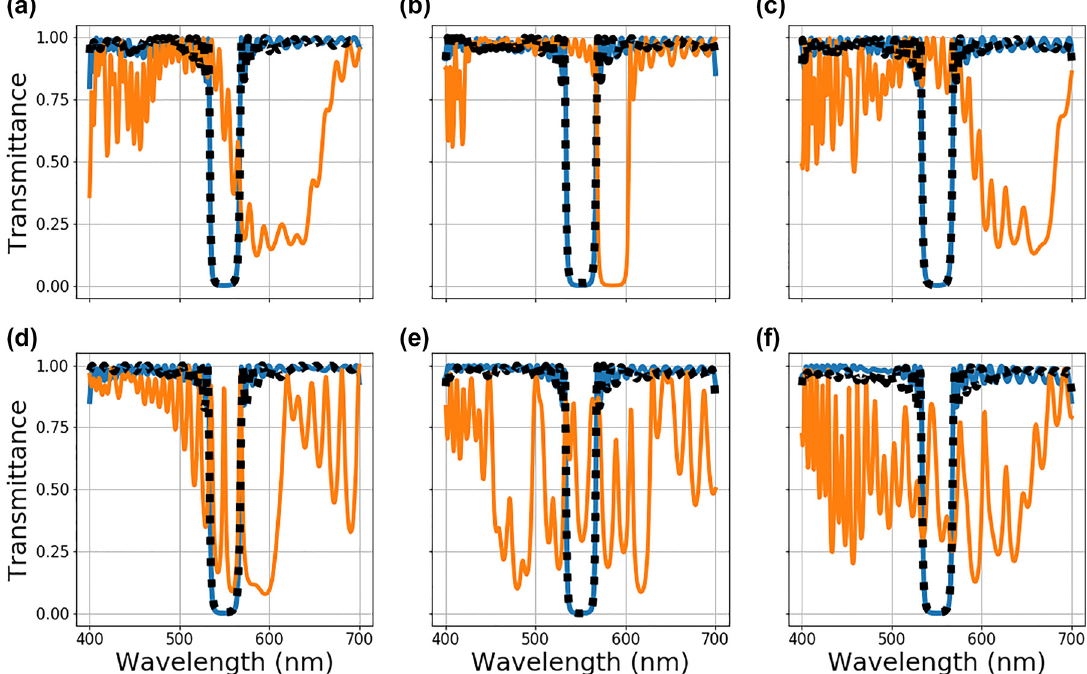
Figure 7: Multilayer stack optimization under deterministic fabrication imperfections. The blue curve represents the spectra of the original ideally optimized stack without any imperfection introduced. The orange curve is the spectra of the same stack but with fabrication errors added. The black dotted curve is the spectra of the stack after the second stage of optimization to compensate for the fabrication errors is complete. The different plots are for different types of systemic error introduced: (a) linear gradient shift, (b) graded transition regions between layers, (c) linear gradient shift and graded transition regions between layers combined, (d)–(f) polynomial, sinusoidal, and exponential height dependent index shifts,